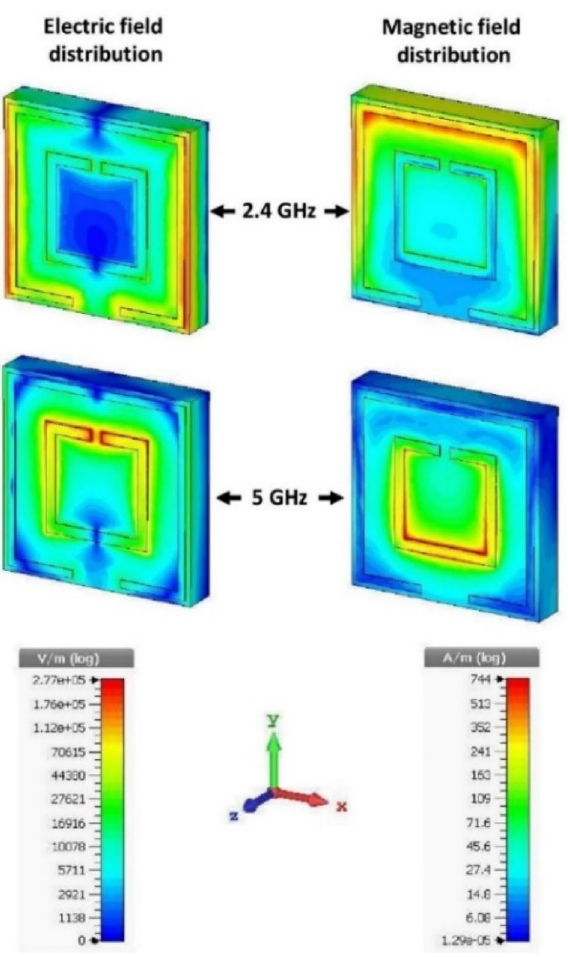
Figure 7. Distribution of the electric field and the magnetic field at 2.4 GHz and 5 GHz on the MM unit cell.